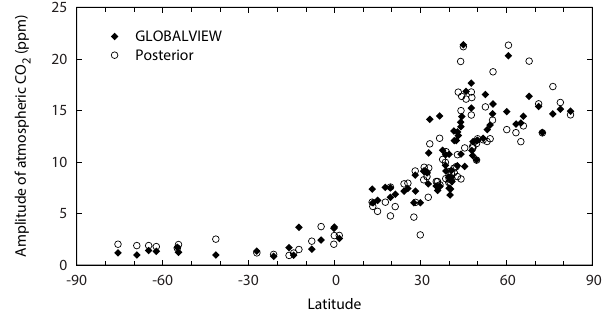
Figure 4. Annual amplitudes of the atmospheric CO 2 variables (ppm) along specific latitudes. The closed diamonds represent the GLOBALVIEW-CO 2 data and the open circles represent the pos- terior parameters. The latitudinal mean amplitudes and standard deviations for each 30 ◦ band from north to south are 15 . 1 ± 1 .